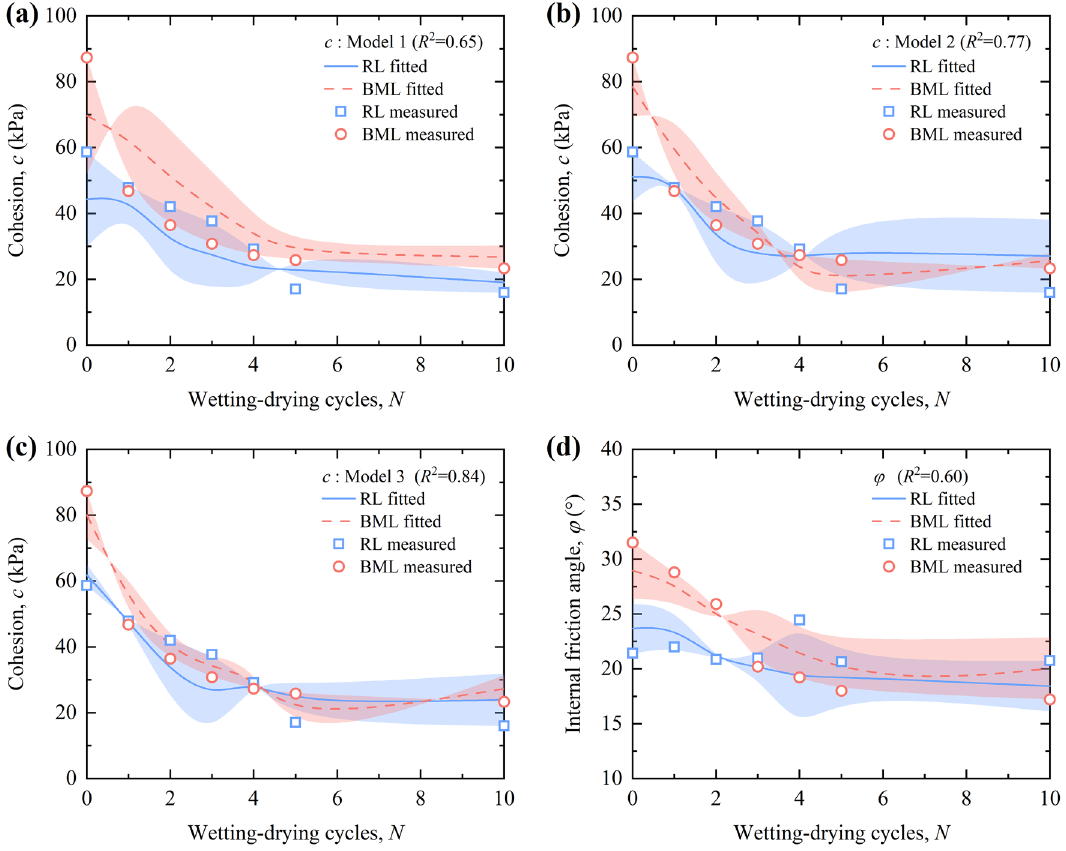
Figure 15. Comparison of measured and fitted values of shear strength